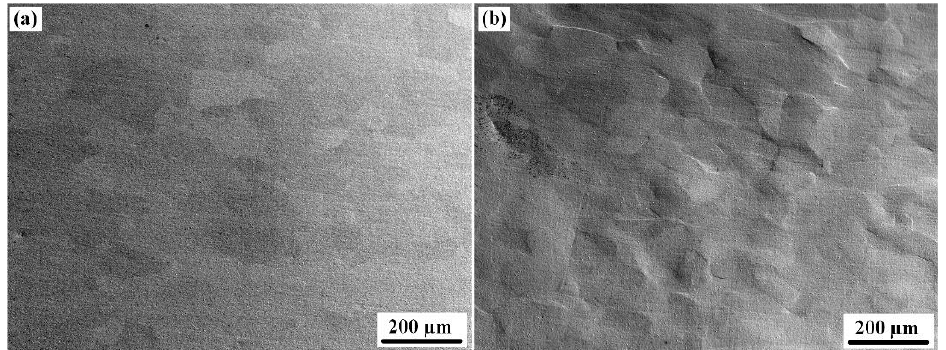
Figure 2. The tracking SE micrographs of the specimen. ( a ) microstructure before compression, ( b ) microstructure of the same area after compression.